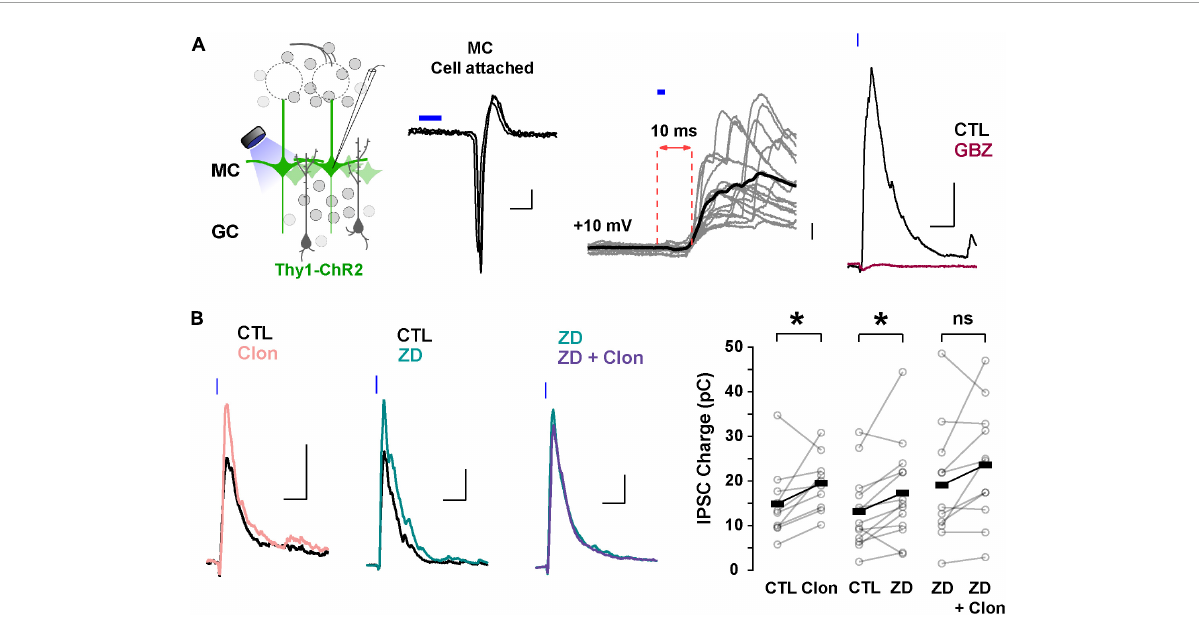
FIGURE6 Suppression of I h by α 2 -AR increases lateral inhibition onto MCs. (A) Left: diagram of the strategy used to elicit lateral inhibition. We recorded from and optogenetically activated MCs expressing the ChR2 protein (Thy1-ChR2 mouse). Right: example of a cell-attached recording showing that activation of ChR2 (2 ms) elicits direct, reliable action potentials in the recorded MC. In voltage-clamp recordings at +10 mV, ChR2 stimulation evokes a disynaptic inhibitory current (10 ms delay) which is abolished by GBZ (10 µ M, brown). The calibration is: cell-attached, 20 pA, 2 ms; whole cell, 50 pA, 50 ms. (B) Representative averaged traces (left) and summary plots (right) showing that α 2 -AR activation by Clon and blockade of I h increased the light-evoked inhibitory currents (Clon, pink, n = 10, * p = 0.04; ZD, teal, n = 13 cells, * p = 0.02). In the presence of ZD, Clon failed to increase the light-evoked inhibitory currents (purple; n = 11 cells, p =